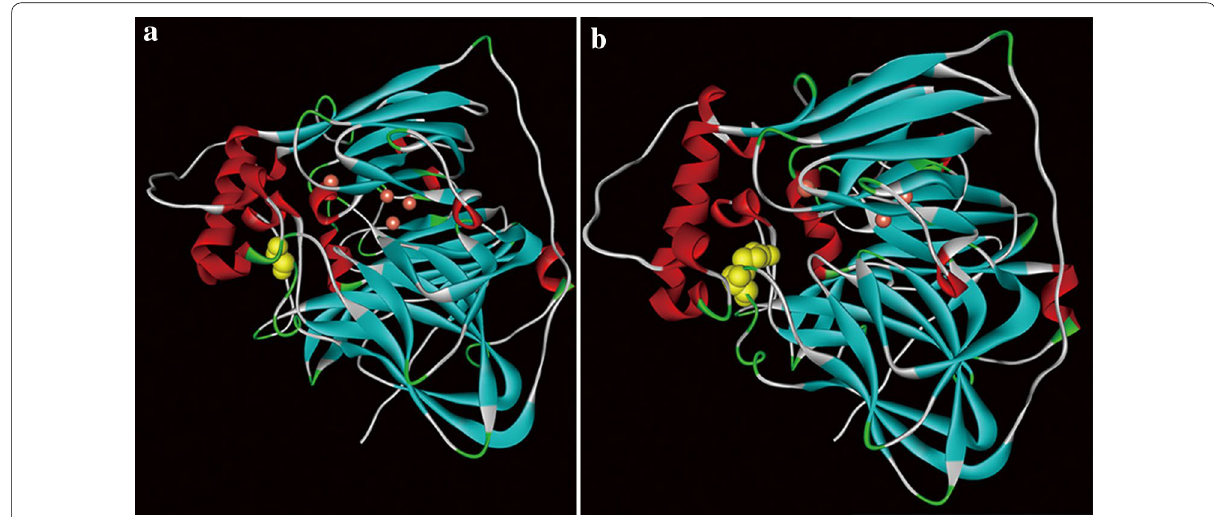
Fig. 6 Structure of wild-type CueO and its mutant (G276R). The Protein Data Bank ID of the wild-type CueO is 3OD3. The mutant G276R was con- structed based on the structure of wild-type CueO, which was modeled using the Discovery Studio 2.5.5 software. The amino acids with the yellow color are the wild G276 (panel a) and R276 (panel